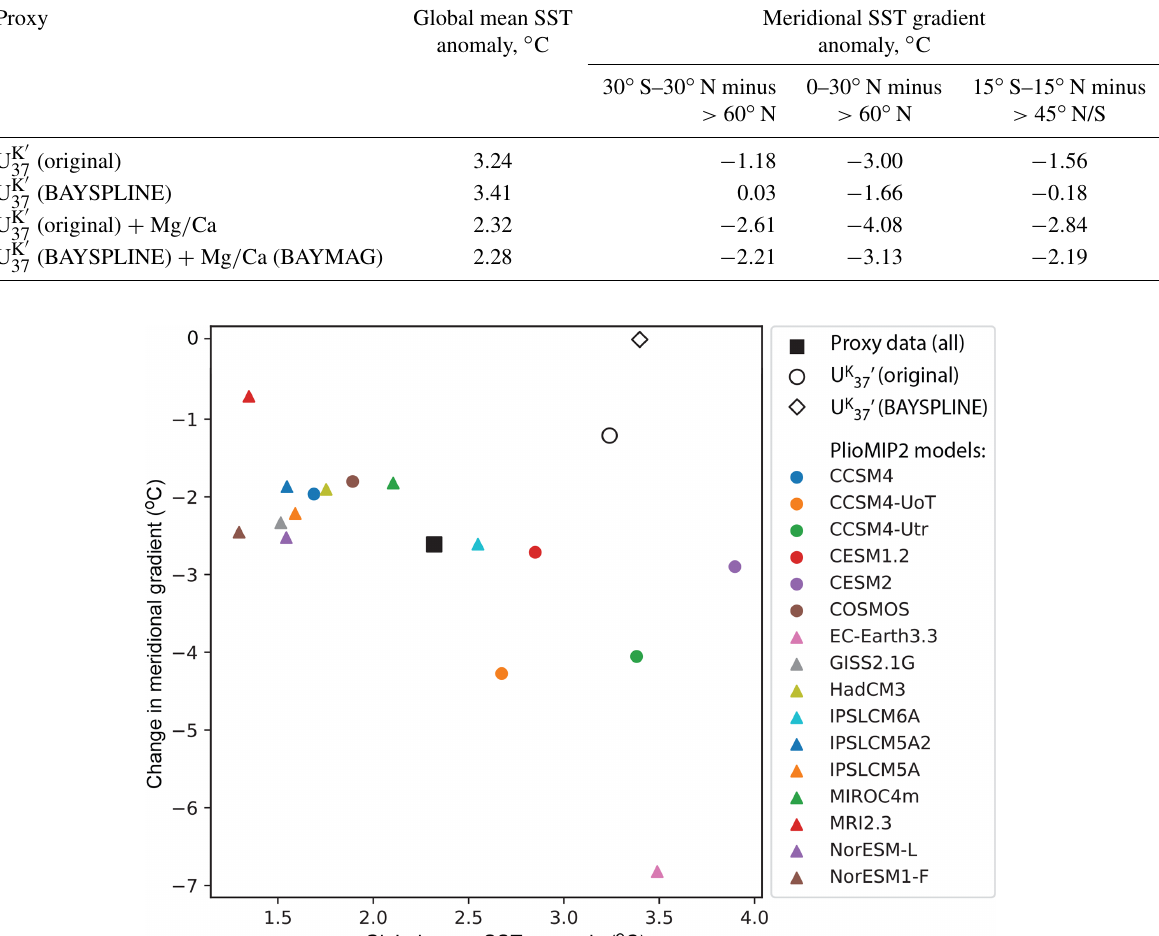
Table 1. Comparison of the magnitude of the global SST anomaly and meridional SST gradients between KM5c and the pre-industrial period, depending on proxy combination, and the latitudinal bands used for the gradient calculations.